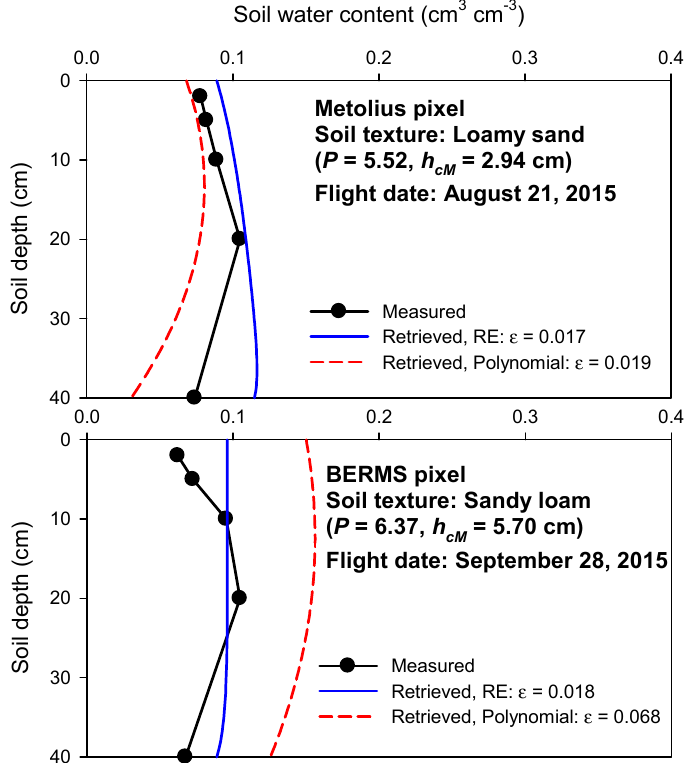
Figure 8. AirMOSS retrieved soil moisture profiles using the new solution (RE) and second order polynomial for two flights over Metolius on 21 August 2015 and over BERMS on 28 September 2015. The inversion accuracy is quantified with the mean absolute error, ε (cm 3 cm − 3 ). BERMS: Boreal Ecosystem Research and Monitoring Site; RE: Richards’ equation.